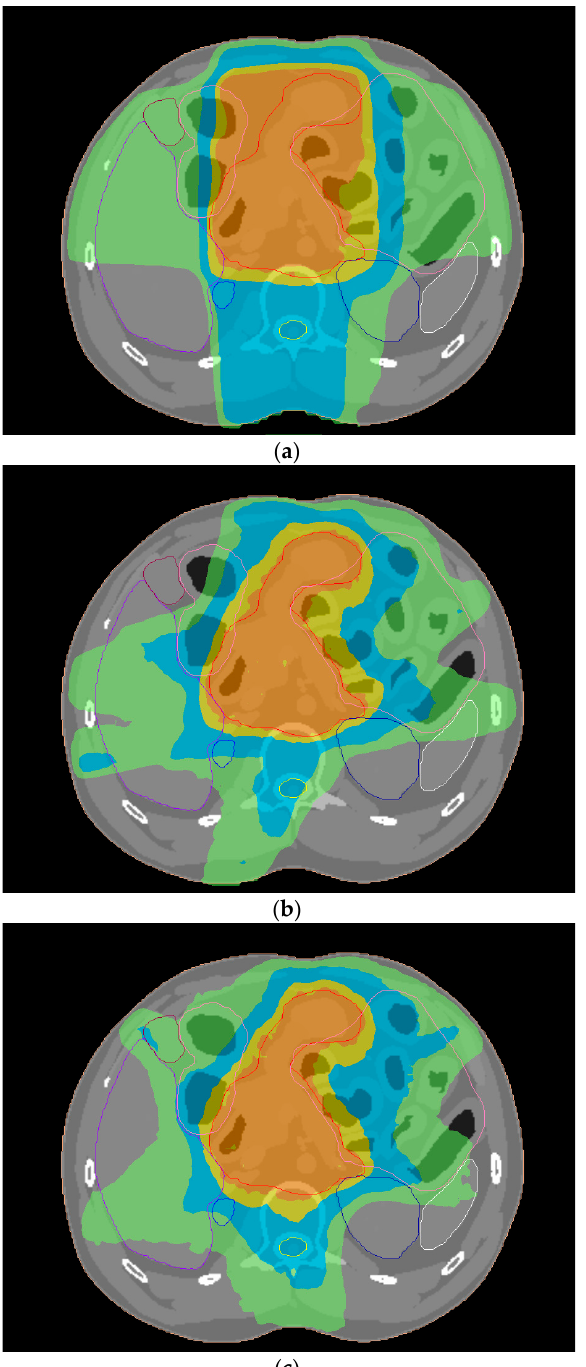
Figure 4. A color wash display of the PTV isodose distribution in an axial CT slice of a phantom simulating a male patient derived from ( a ) 3D-CRT, ( b ) IMRT and ( c ) VMAT plans with 6 MV photons. The isodoses of 100, 90, 65 and 45% are shown in orange, yellow, blue and green colors, respectively. The PTV is presented with the red contour.